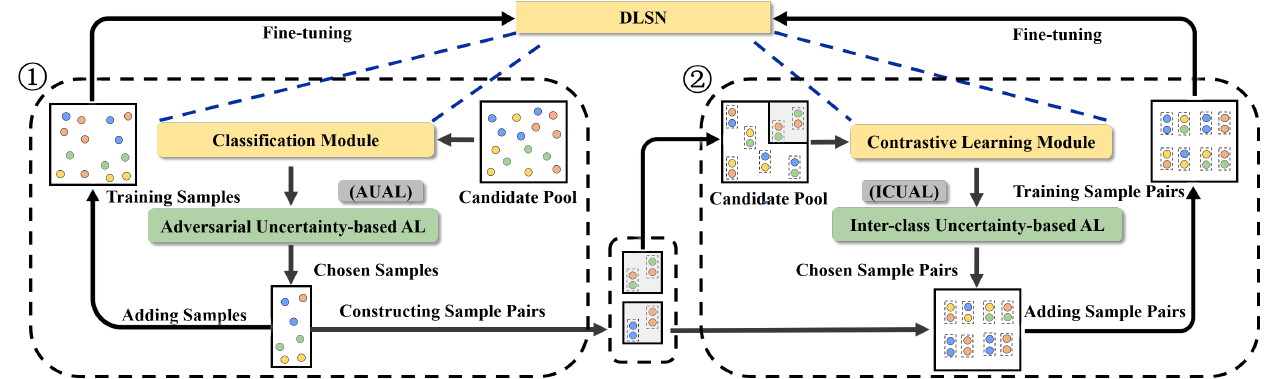
Figure 1. Graphical illustration of active learning-driven siamese network (ALSN). First, the clas- sification module of DLSN is used to actively query instances for fine-tuning and new sample pair construction. Second, the contrastive learning module is used to actively query instances with inter-class uncertainty from the negative sample pair pool for fine-tuning.